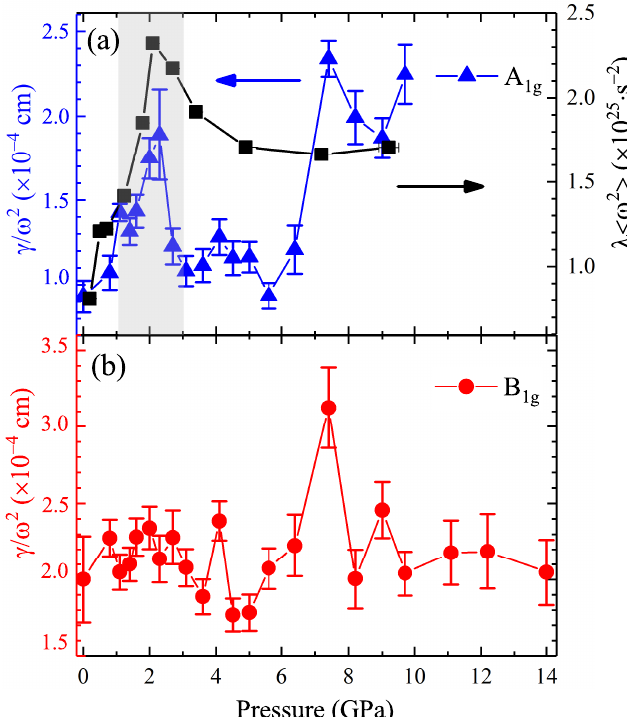
Figure 6. Pressure-dependent parameters of the electron–phonon coupling strength. The blue and red symbols denote the electron–phonon coupling constants obtained from the vibrational properties of the ( a ) A 1 g and ( b ) B 1 g phonon modes. The black symbols plotted are the calculated second term of the Eliashberg function. Figure ( a ) is plotted as a double-Y-axis